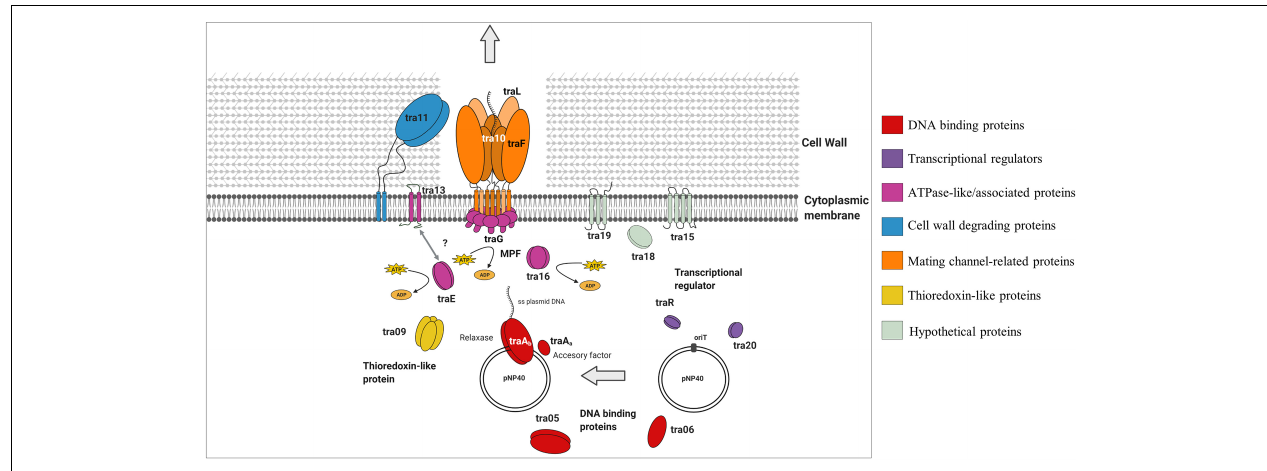
FIGURE 5 | Schematic representation of the role that the different gene products from the pNP40 conjugation cluster play during the transfer of ssDNA in a conjugation event in a Gram-positive bacterium. This functional model is based on the mutational analysis of the eighteen genes that encompass this conjugation operon, paired with a predictive functional analysis based on sequence and structural similarities, although it should be emphasized that the function of many of these proteins requires experimental